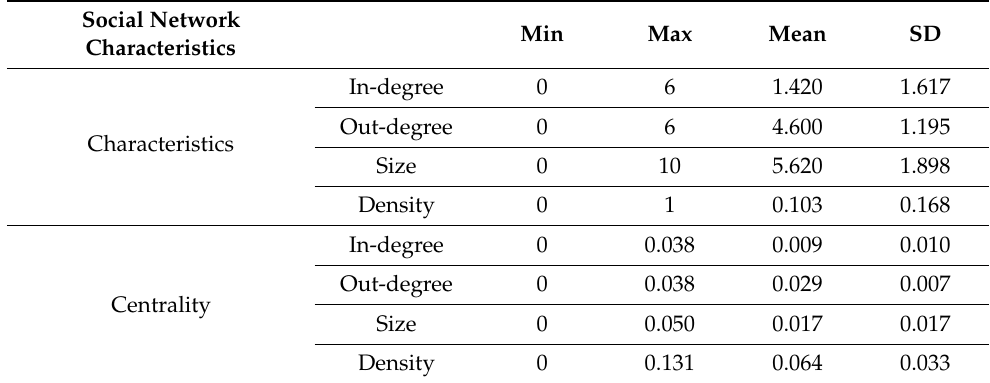
Table 3. Social network